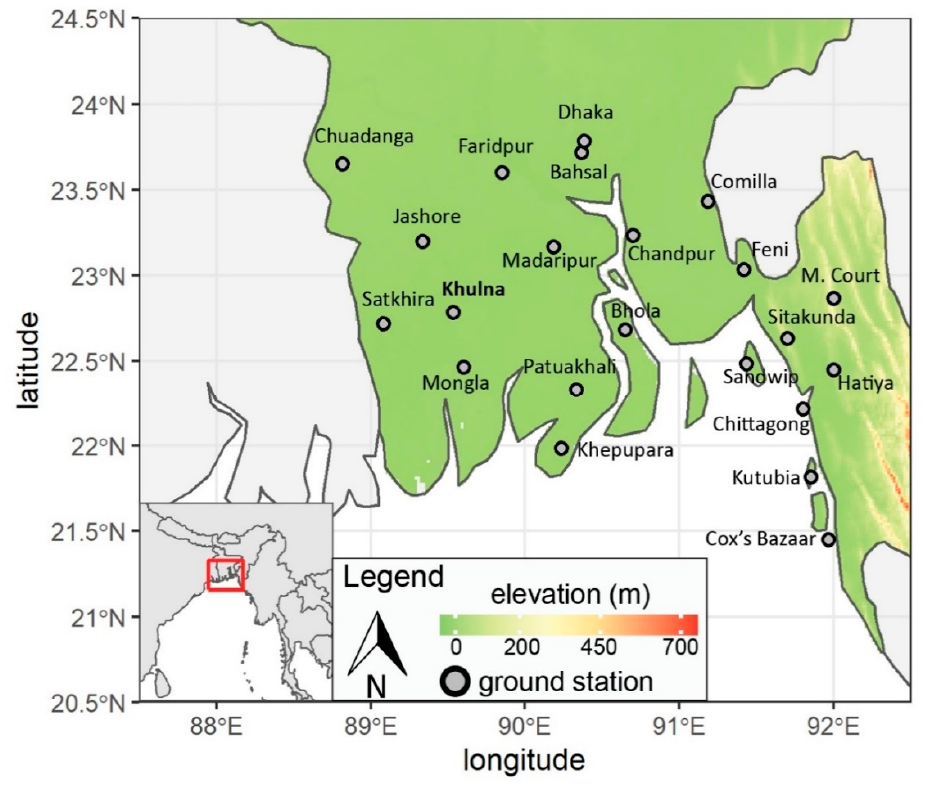
Figure 1. General location of the study area including the ground stations that were employed in the current study.